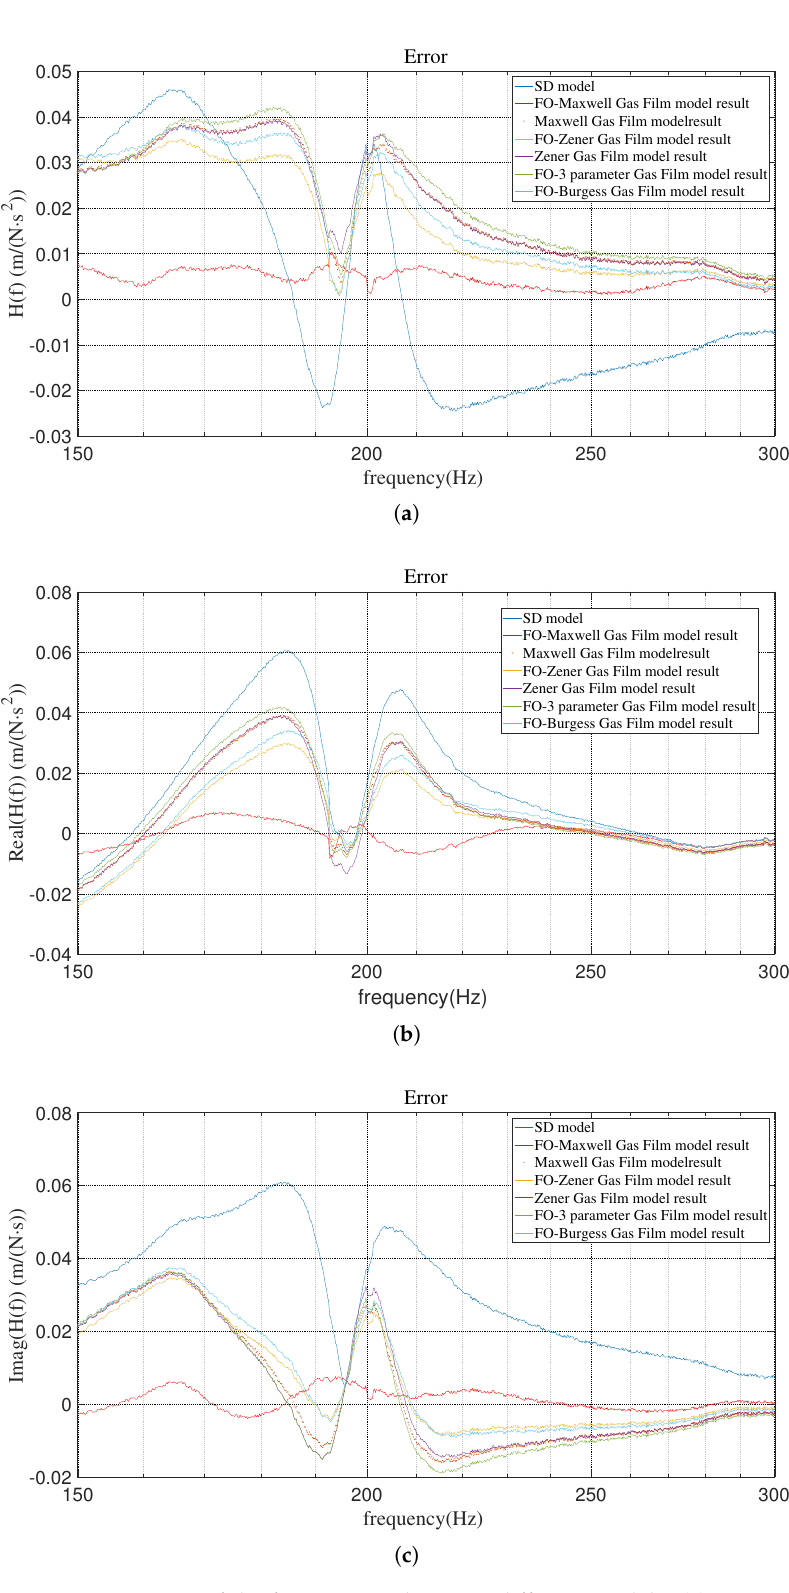
Figure 19. Comparison of the fitting errors between different models. ( a ) Error value of transfer function H af . ( b ) Error value of the real part. ( c ) Error value of the imaginary part. For the experimental platform in this paper, the capture effects of different models were sorted from best to worst as follows: FOMGF model ( E = 86.19%, E m =